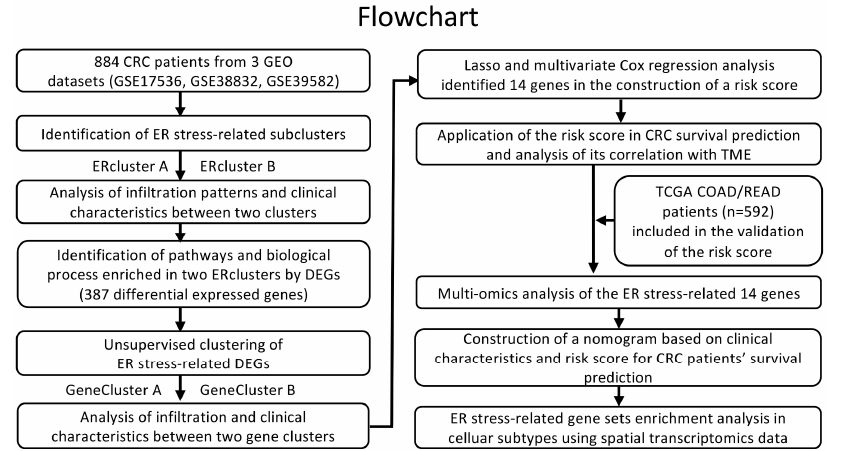
Figure 1. Overview of the analysis workflow.